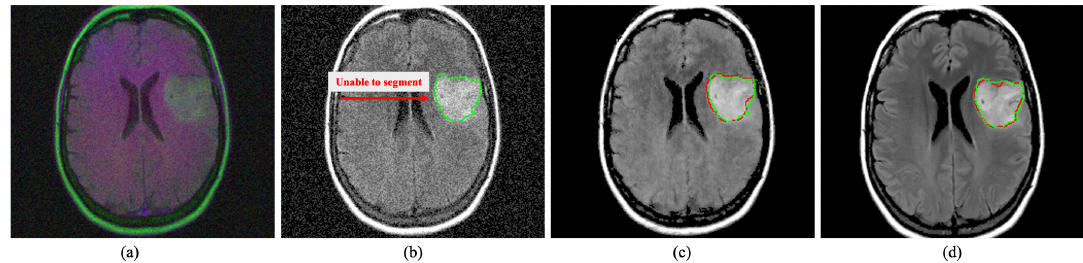
Figure 10. Segmentation on brain MRI image. The green and red outline indicate the ground truth and the segmented area. The proposed DRAN can drastically improve the segmentation performance by excluding the noise present in the target image. ( a ) Noisy image. ( b ) Noisy image + U-Net [68]. ( c ) Denoised image obtained with DRAN + U-Net [68]. ( d ) Reference clean image + U-Net [68]. Source by: (https://www.kaggle.com/mateuszbuda/lgg-mri-segmentation).